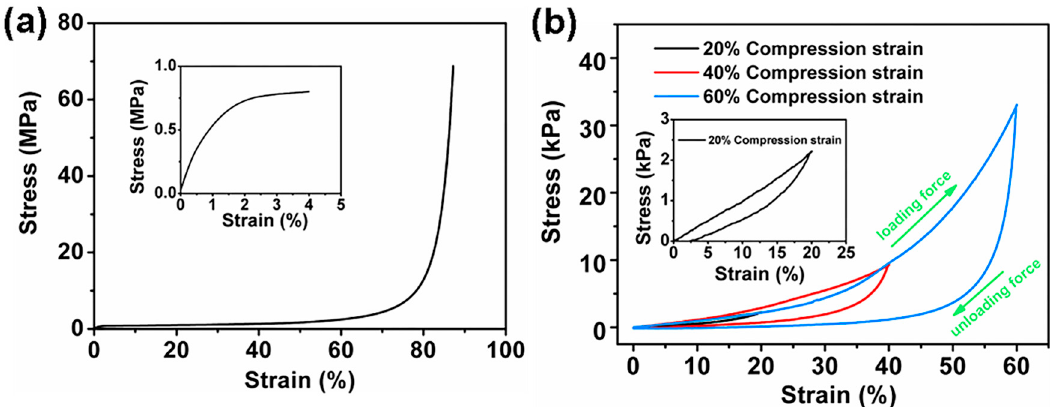
Figure 6. Stress-strain curves of the ( a ) natural wood and ( b ) wood aerogel-8 h under compression.